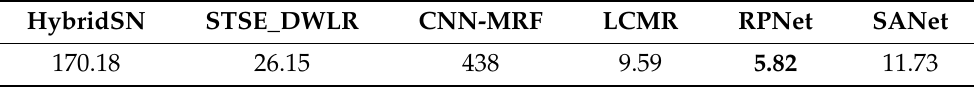
Table 2. Running time of different methods on Indian Pines data set (S).